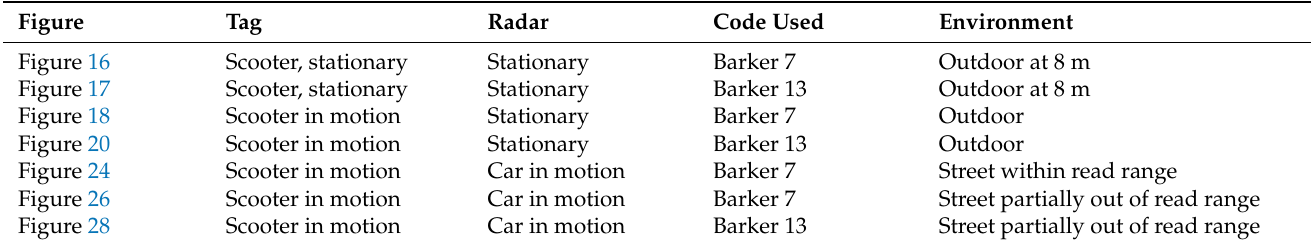
Table 2. Summary of measured